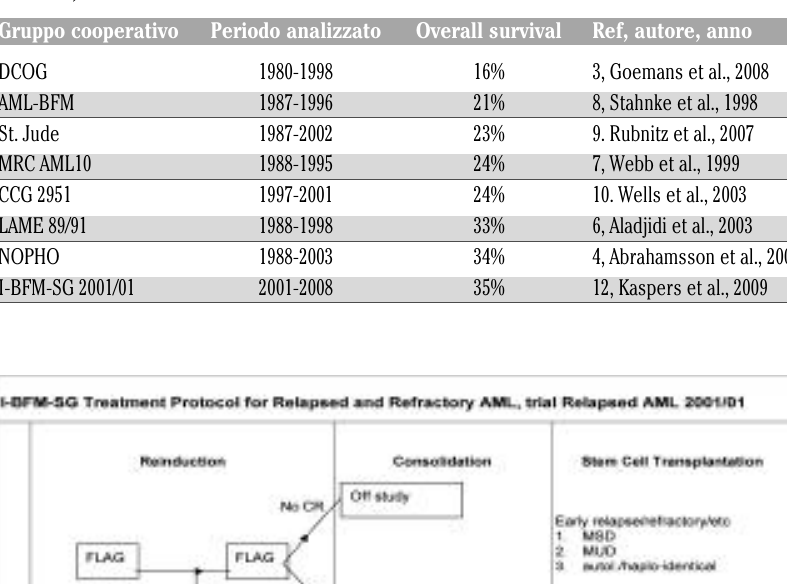
Tabella 2. Overall survival (in ordine crescente di risultato) riportata in letteratura da vari gruppi cooperativi internazionali in bambini affetti da LMA (sono escluse le LMA con FAB M3) resistente o recidivata.